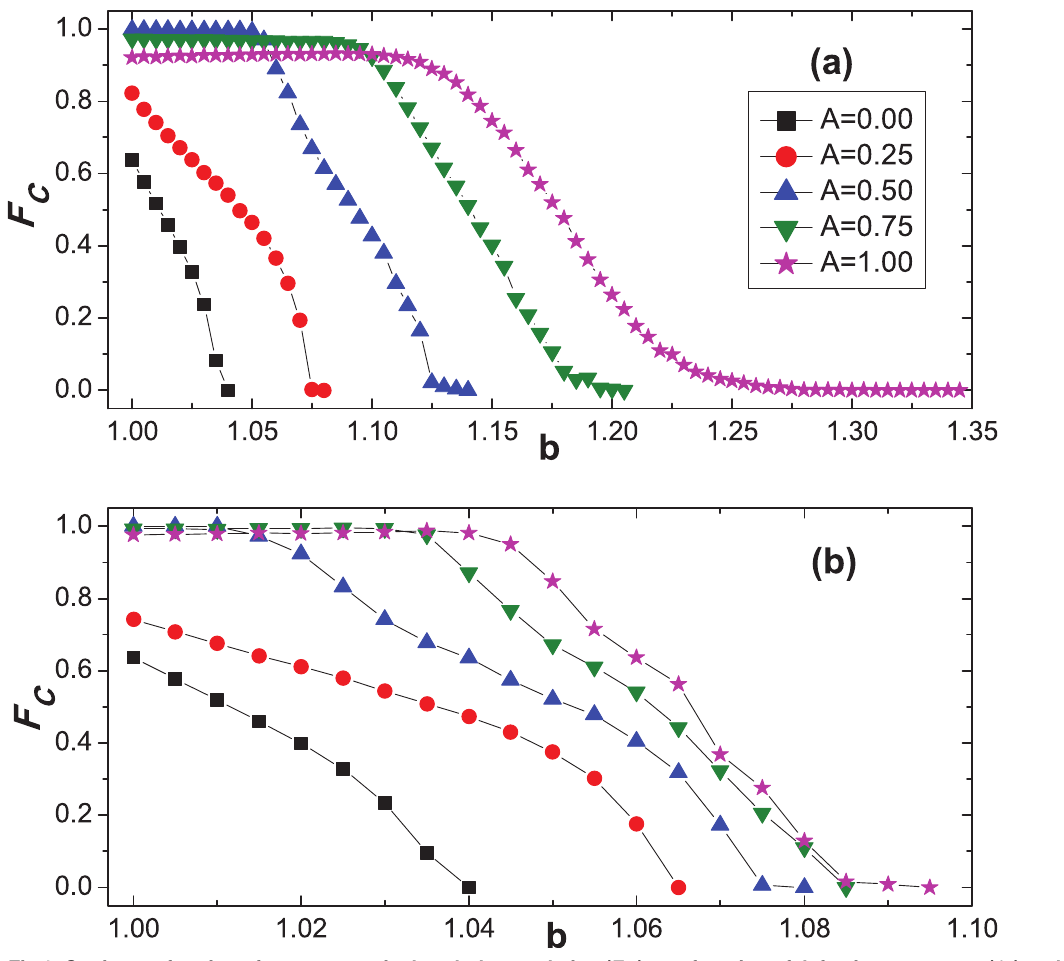
Fig 1. Stationary fraction of cooperators in the whole population ( F C ) as a function of defection parameter ( b ) under different amplitude of coupling strength ( A ). On the top panel (a), corresponding players on two networks always have the same coupling strength which is taken from the interval [ − A , A ] according to Eq (2), and the cooperation can be greatly promoted as A increases; On the bottom panel (b), corresponding players on two networks hold distinct coupling strengths which are independently derived from Eq (2), and the cooperation is also promoted but the enhancement level is much smaller than that in the top panel. Other parameters are set to be L = 200 and K =